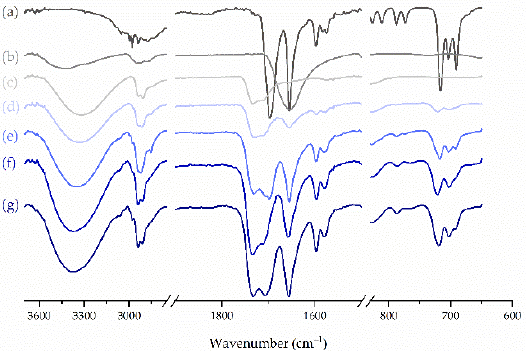
Figure 7. Selected FTIR spectra of investigated systems: ( a ) ketoprofen, ( b ) Kollidon ® CL, ( c ) PVA, ( d ) F1, ( e ) F3, ( f ) T3, ( g ) F6.